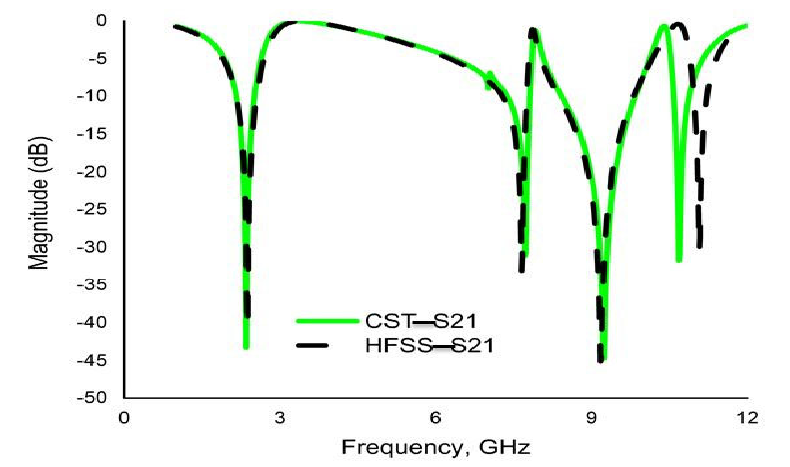
(cid:4667) simulated by CST and HFSS. Figure 19. Comparison of transmission coefficients ( S 21 ) simulated by CST and (cid:2870)(cid:2869)